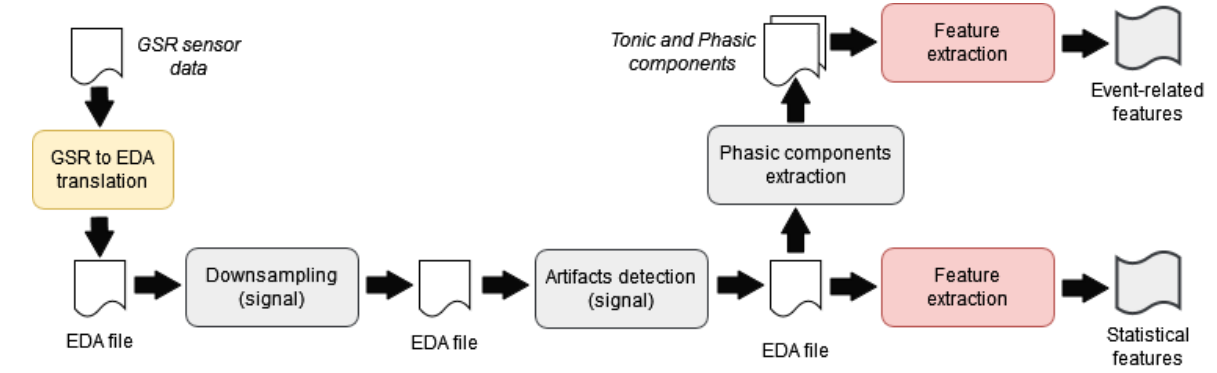
Figure 3. Stages involved in the feature extraction from the files of sensor